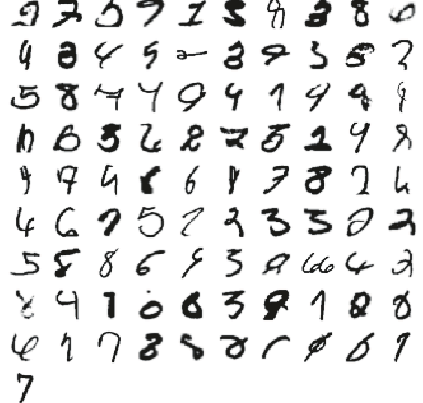
Figure 10: Sample of 100 misclassified images in the EMNIST Letters test set with the best committee found.